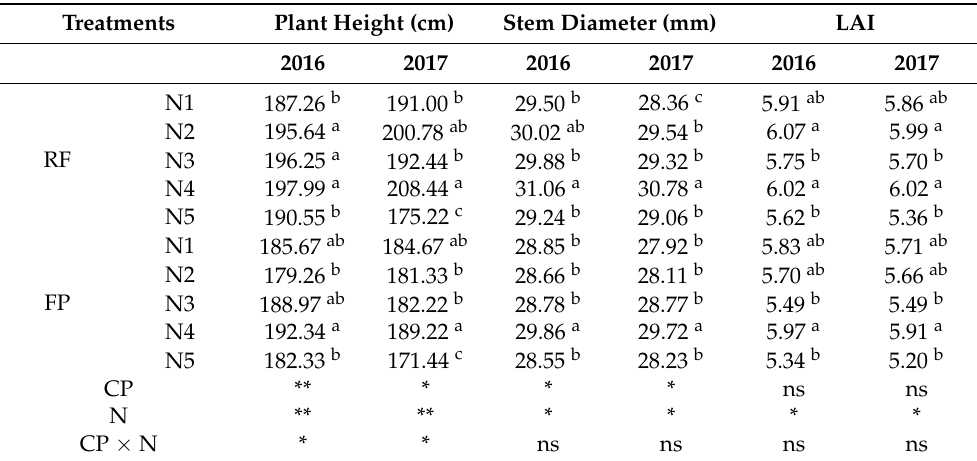
Table 3. Effect of culture practice and nitrogen fertilizer on plant height (cm), stem diameter (mm), and LAI at harvest of spring